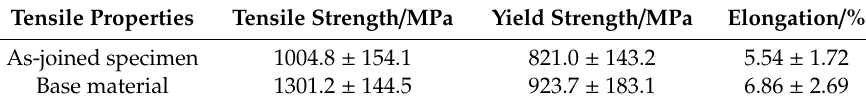
Table 3. Tensile testing results of the joined material and base material.